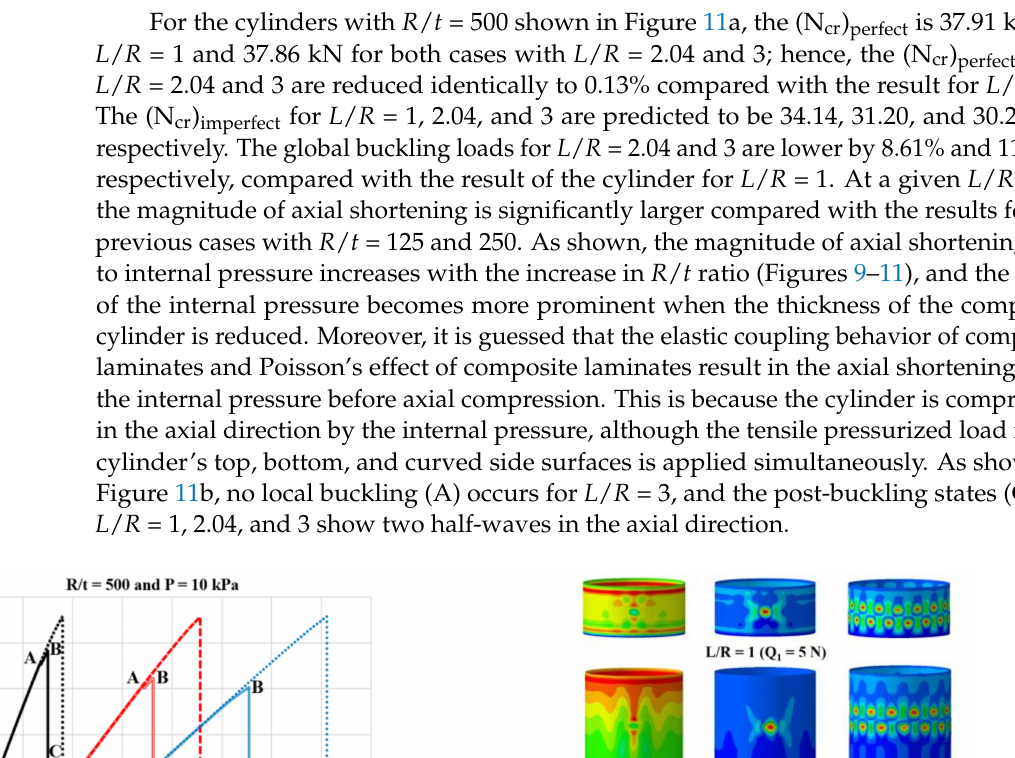
Figure 10. Post-buckling analyses results under axial compression and internal pressure (10 kPa) for the cylinders R / t = 250. ( a ) Load-displacement curves, ( b ) Buckling shapes.